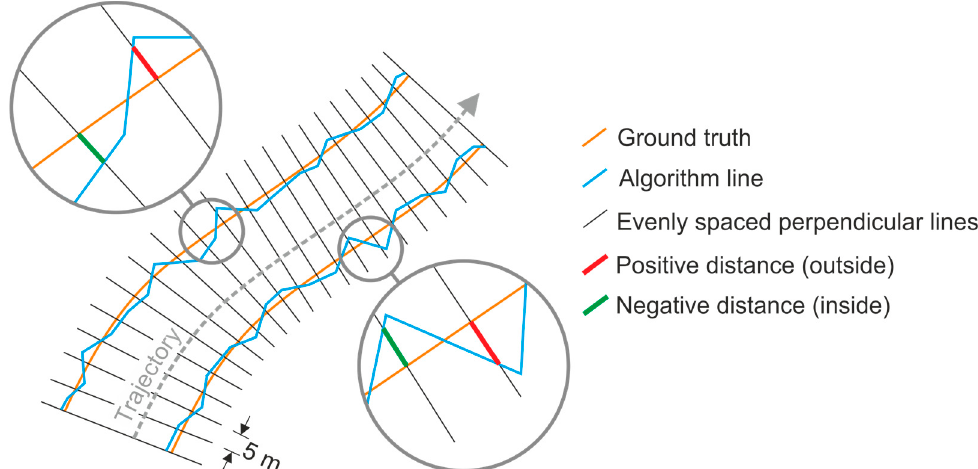
Figure 9. Measurement of distances (GroundTruth) → (AlgorithmLine). When the Algorithm line is closer to the trajectory than the Ground Truth line , distances along the perpendicular lines are stored as negative values, and as positive values otherwise.